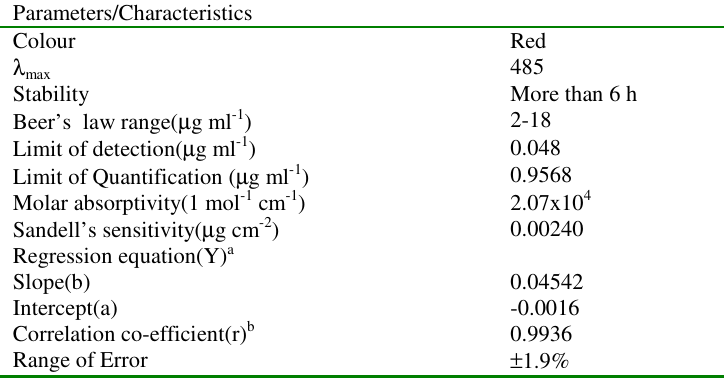
Table 1 . Optical characteristics and precision